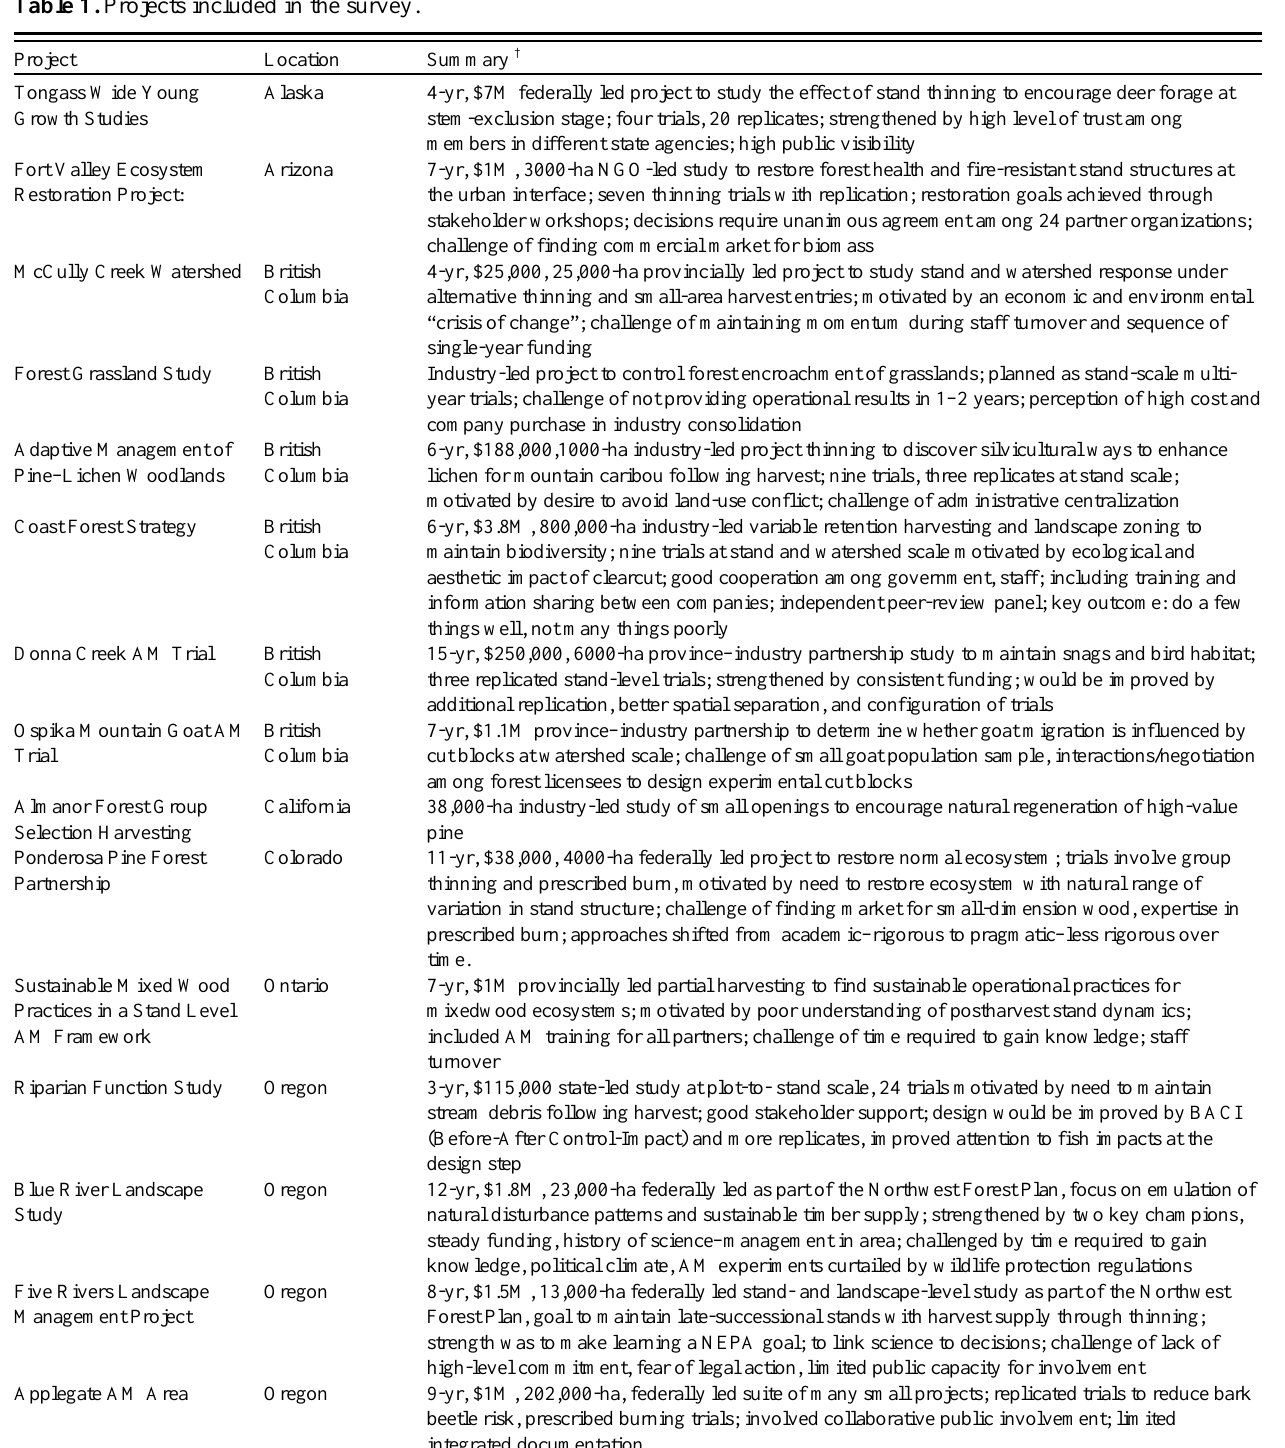
Table 1. Projects included in the